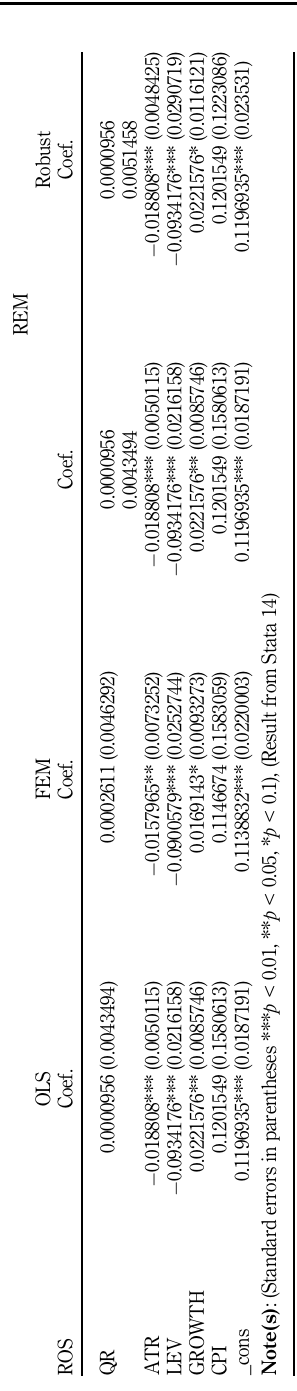
Table 8. Regression